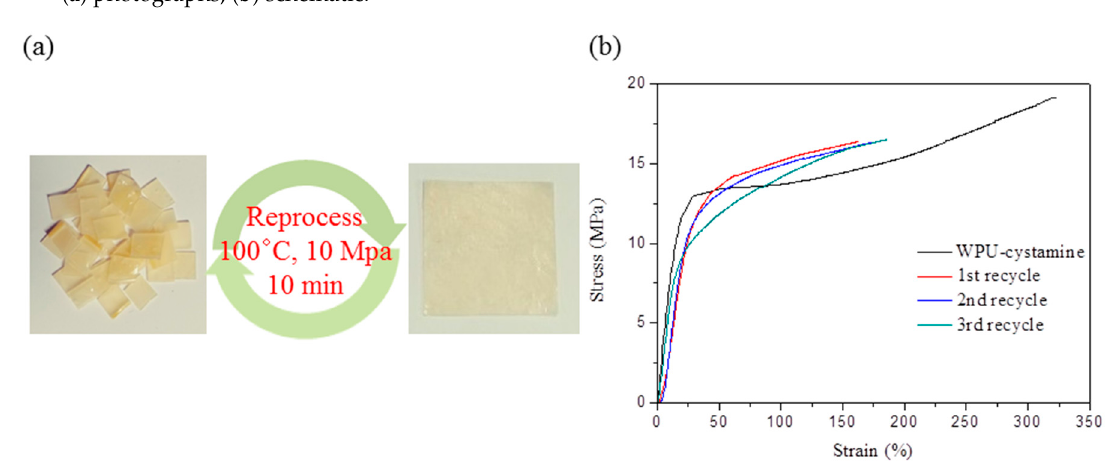
Figure 9. ( a ) Reprocessing image of the WPU-cystamine films. ( b ) Stress–strain curves of (WPU-cystamine) and reprocessed films (1st, 2nd, and 3rd unprocessed (WPU-cystamine) and reprocessed films (1st, 2nd, and 3rd recycle).